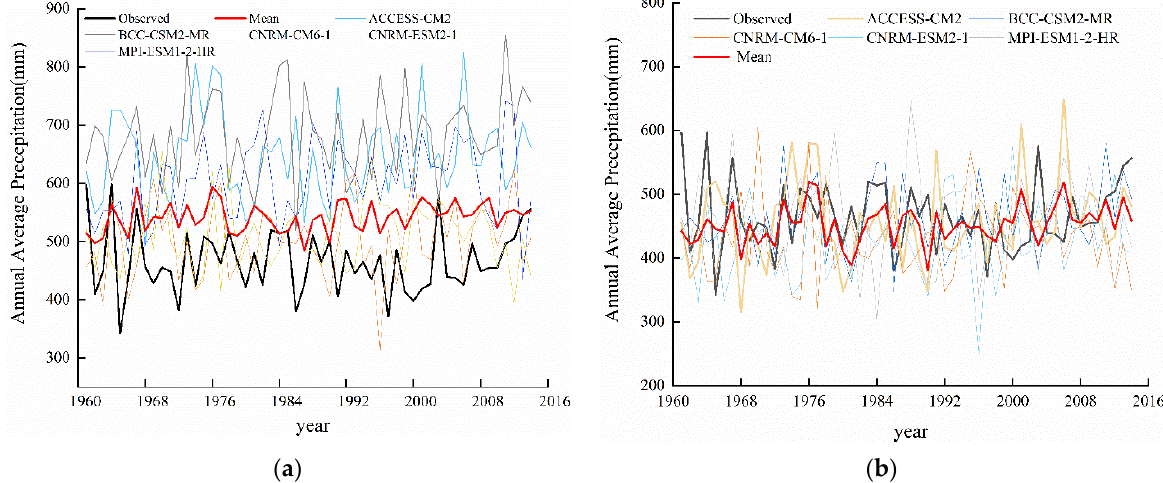
Figure 2. Annual average precipitation before and after bias correction from model simulation and observation during the historical period (1961–2014) over Yellow River Basin. ( a ) Before the bias correction and ( b ) after the bias correction; the “Mean” is the average ensemble model, and “Observed” is the observation.